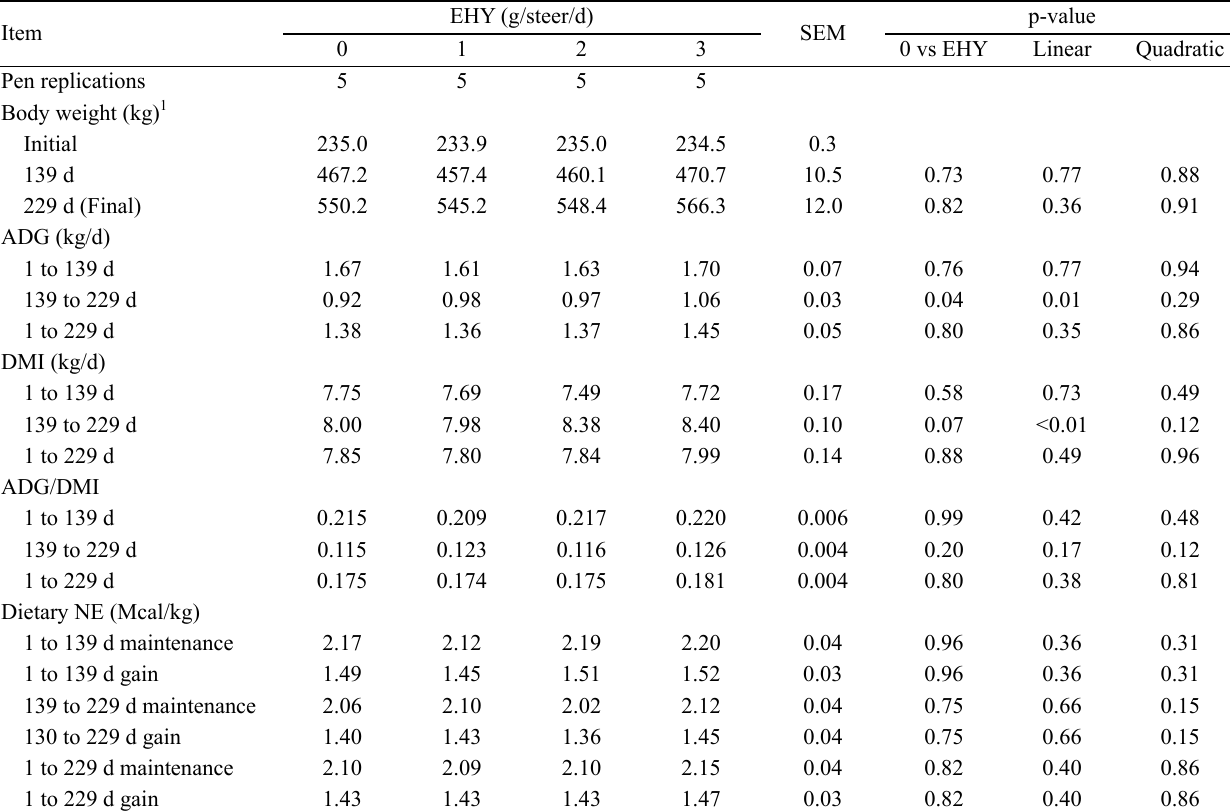
Table 2. Influence of enzymatically hydrolyzed yeast (EHY) supplementation on growth-performance of crossbred feedlot steers EHY Item